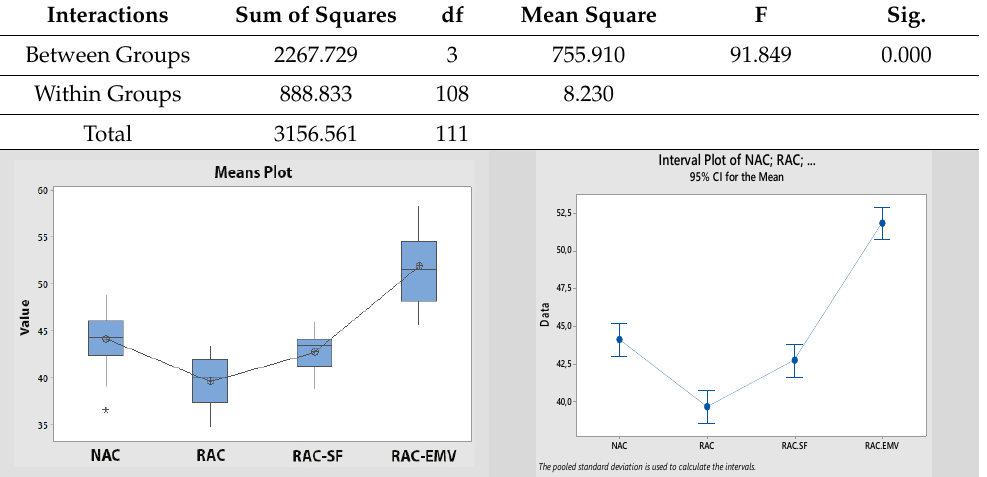
Table 10. Games-Howell Multiple Comparison test results and test